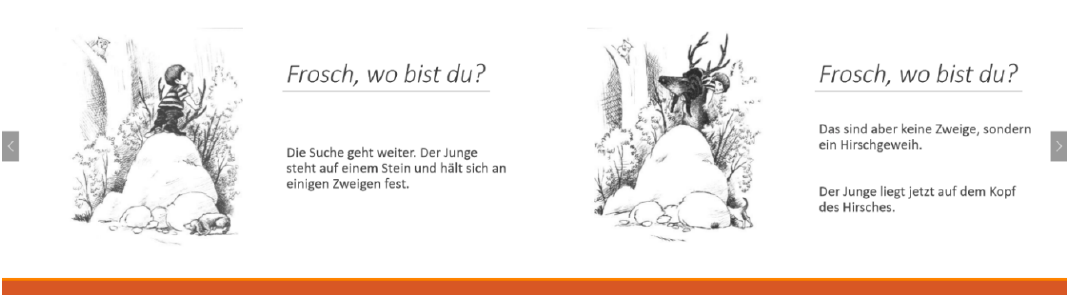
Figure A8. Pretest: Production task.